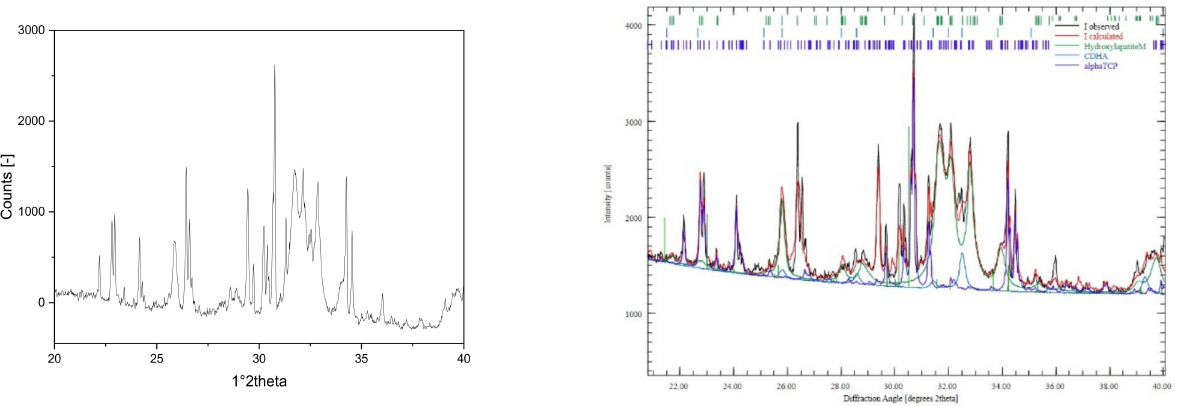
Figure A2. XRD pattern and Rietveld refinement calculation of the CPC paste; XRD pattern taken with Bruker D8 advance with 40 kV/40 mA, 1 ◦ 2 theta/min, and step size of 0.02 ◦ 2 theta; Rietveld refinement calculated with Profex